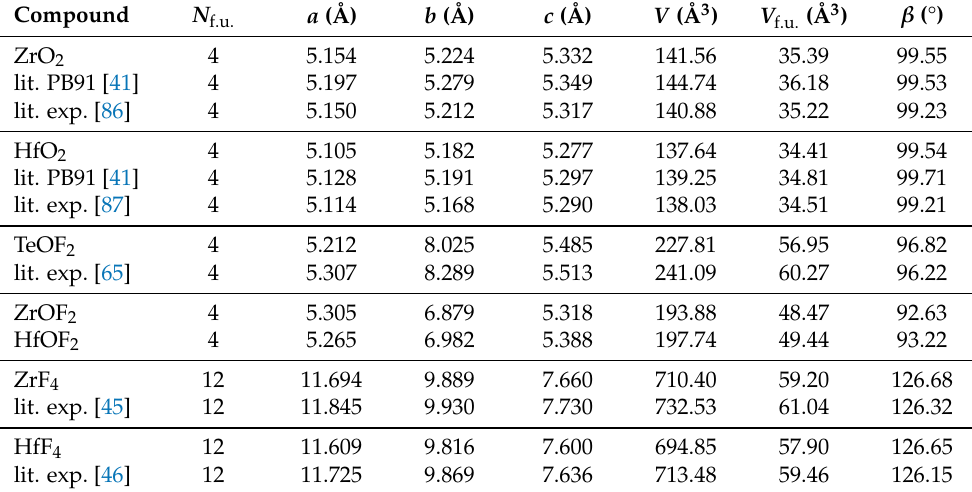
Table 1. Relaxed unit cell parameters vs. experimental (lit. exp.) and calculated literature (lit. PB91) values. Given are the number of formula units per unit cell ( N f.u. ), unit cell vector lengths ( a , b , c ), unit cell volume ( V ), unit cell volume per formula unit ( V f.u. ), and the non-orthogonal angle ( β ); note that α = γ = 90°. Compound N